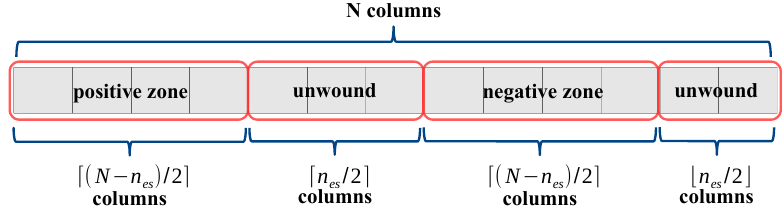
Figure 5. A possible WDT for single phase